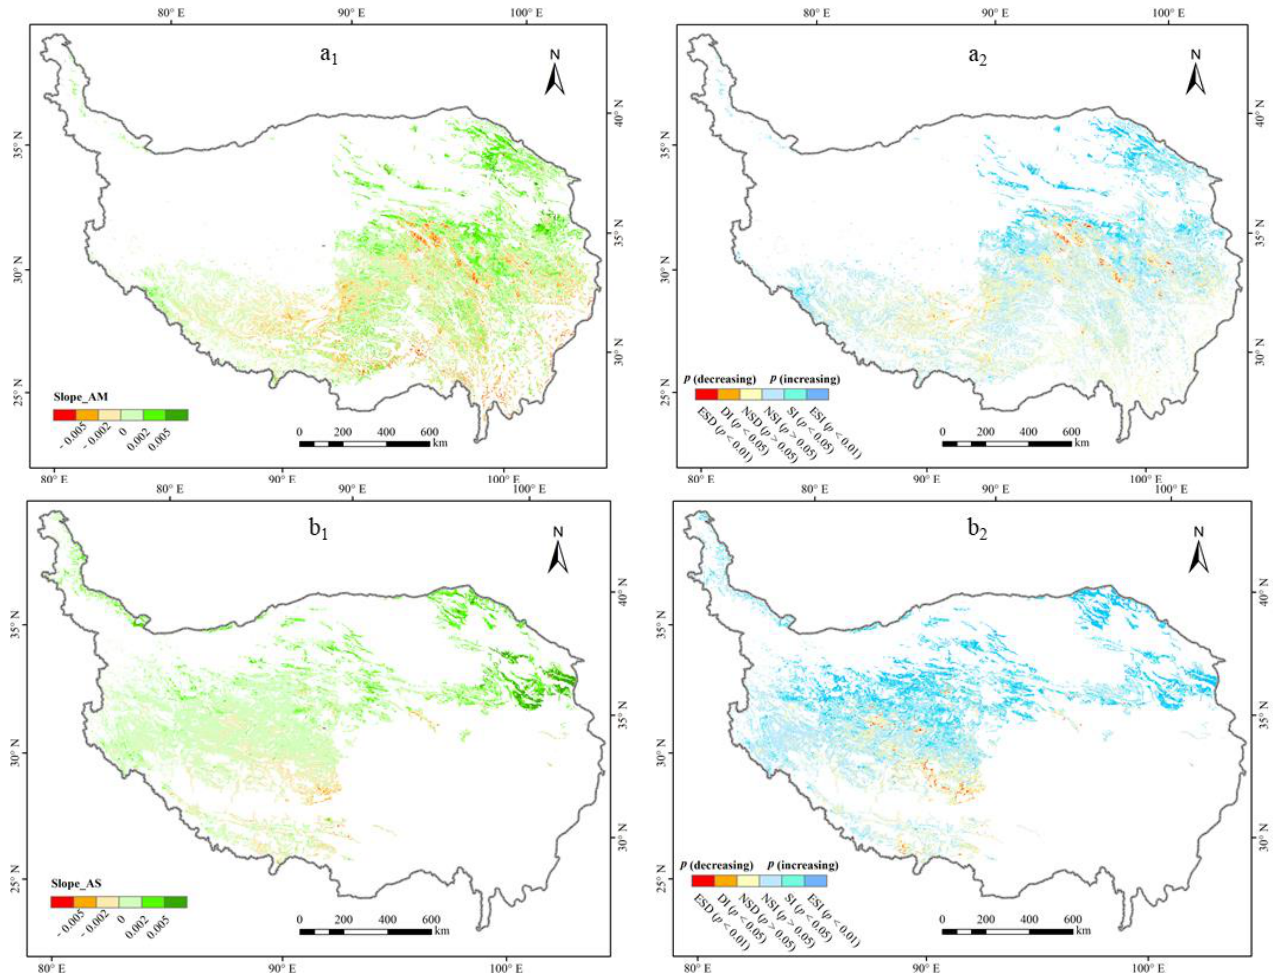
Figure 7. Spatial distribution of the AM_NDVI slope ( a 1 ) and its significance level (SL) ( a 2 ) and the AS_NDVI slope ( b 1 ) and its significance level (SL) ( b 2 ) during the growing season from 2000 to 2018. p (decreasing) and p (increasing) are the p values of the decrease and increase for the growing season NDVI, respectively, which are divided into three levels: p < 0.01, 0.01 < p < 0.05, and p >